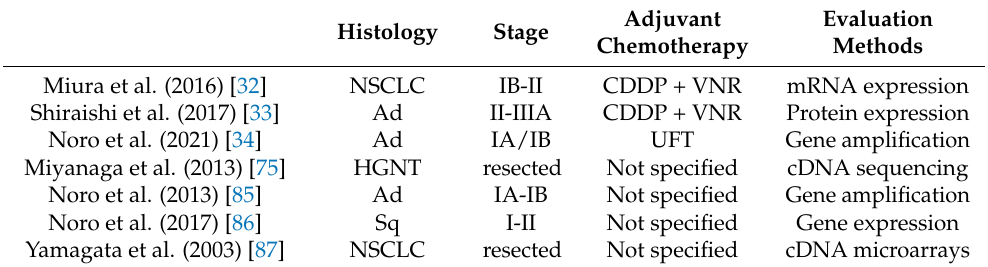
Footnotes: Ad, adenocarcinoma; CDDP, cisplatin; cDNA, complementary DNA; HGNT, high-grade